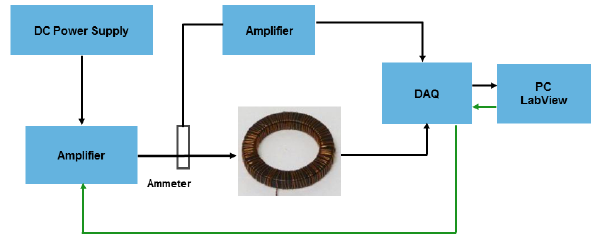
Figure 1: Scheme of magnetic measurement system